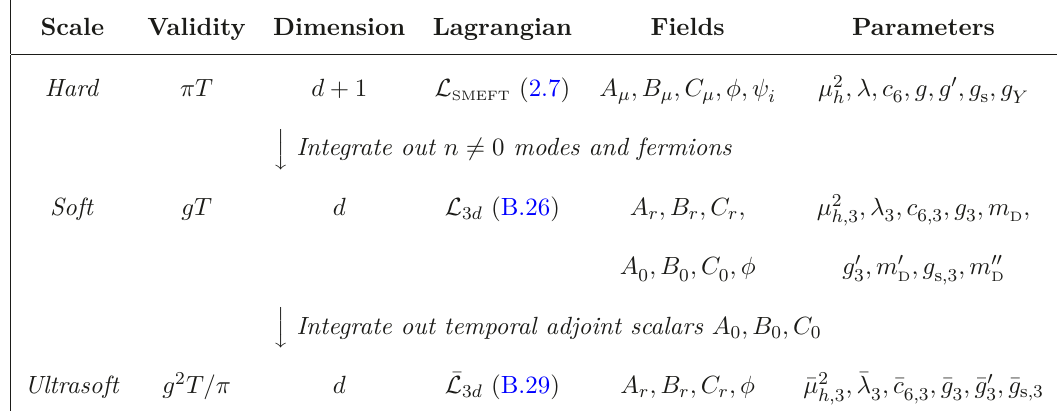
Table 2 . Dimensional reduction of ( d +1)-dimensional SMEFT into effective d -dimensional theories based on the scale hierarchy at high temperature. The effective couplings are functions of the couplings of their parent theories and temperature and are determined by a matching procedure. The first step integrates out all hard non-zero modes. The second step integrates out the temporal adjoint scalars A , B , C with soft Debye masses m , m ′ , m ′′ . At the ultrasoft scale, only ultrasoft 0 0 0 D D D spatial gauge fields A r , B r , C r (with corresponding field-strength tensors G rs , F rs , H rs ) remain along with a light Higgs that undergoes the phase